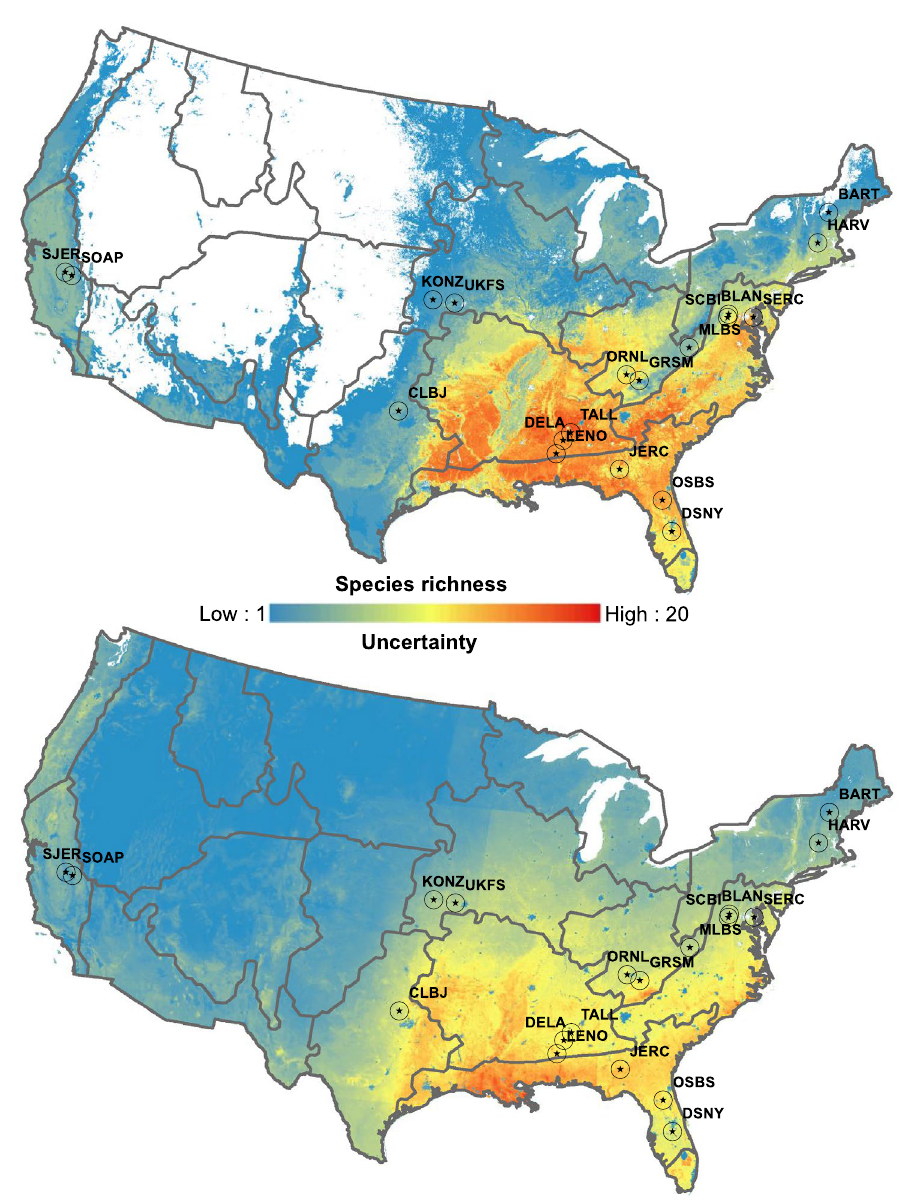
Figure 2. Macroecological patterns of the number co-occurring oak species (top panel) and uncertainty (low panel) estimated by stacking individual species distribution model binary predictions (S-SDMs). Numbers on the legend represent the number of co-occurring within each pixel. In addition, blue and red colors mean low and high species co-occurrence (uncertainty), respectively. Star symbols (and acronyms) on the map represent the nineteen NSF-NEON sites that have data of oak species assemblages. Overlaid gray polygons represent the NSF-NEON ecoclimatic domains. Map projection: Lambert Azimuthal Equal Area. Maps were generated using ArcGis Desktop 10.6 (https:// deskt op. arcgis.